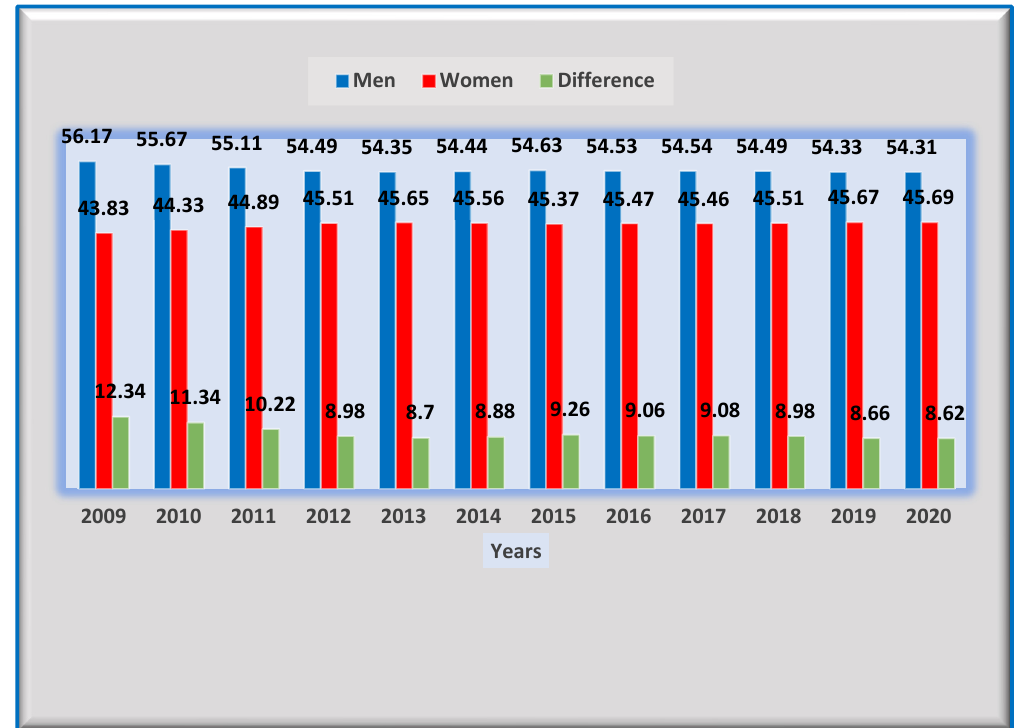
Figure 5. Employed persons by sex (percentages). Source: Authors with data from the Statistics National Institute ( Instituto Nacional de Estadística ).